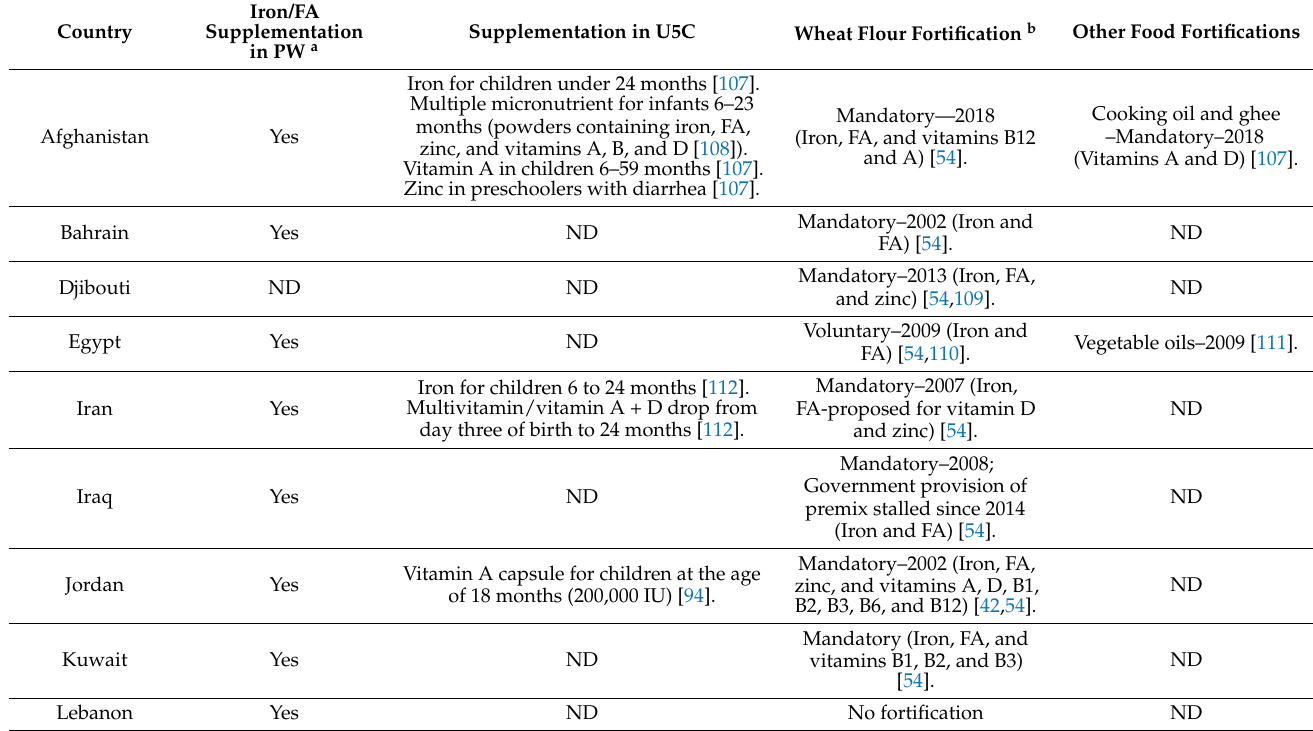
Table 3. Nutrition-specific interventions to reduce anemia in countries of the